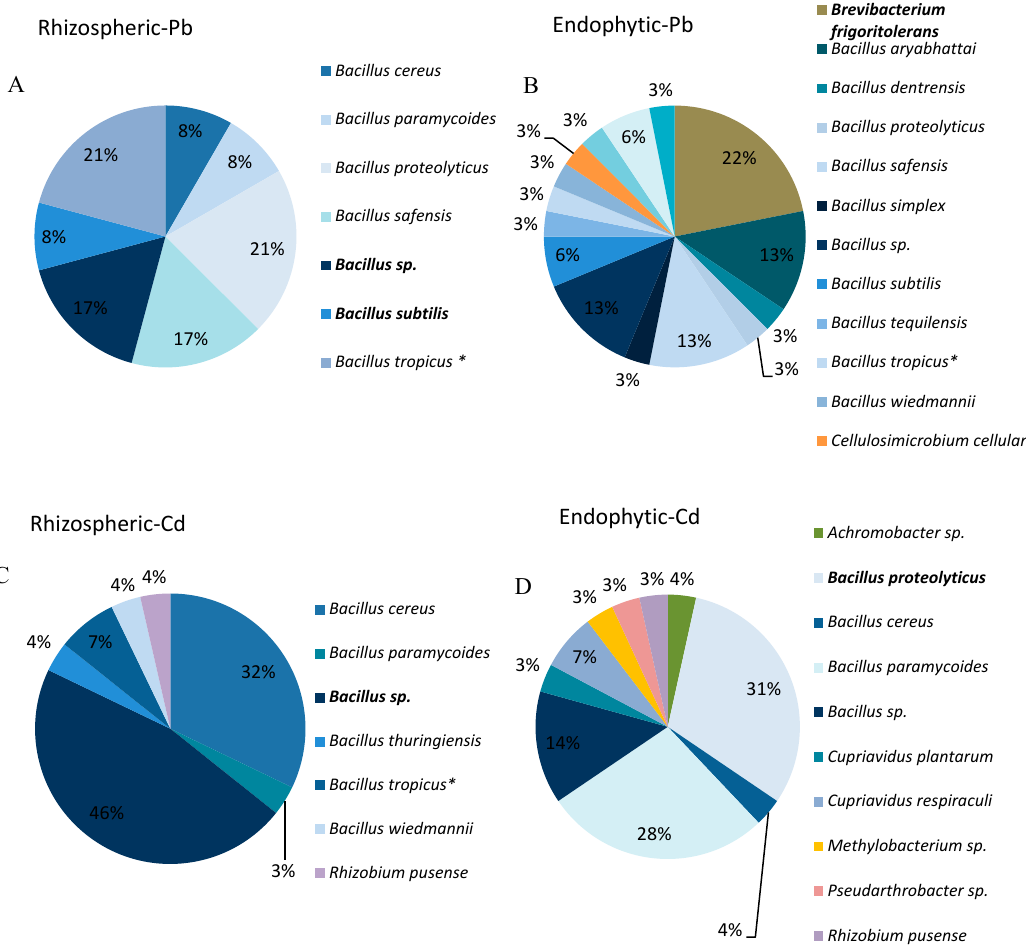
Figure 1. ( A ) Root rhizospheric and ( B ) endophytic Pb tolerant bacterial; and ( C ) root rhizospheric and ( D ) endophytic Cd tolerant bacterial strains; isolated onto heterotrophic glucose-yeast medium, from roots of H. petiolaris plants, grown in polluted soils.